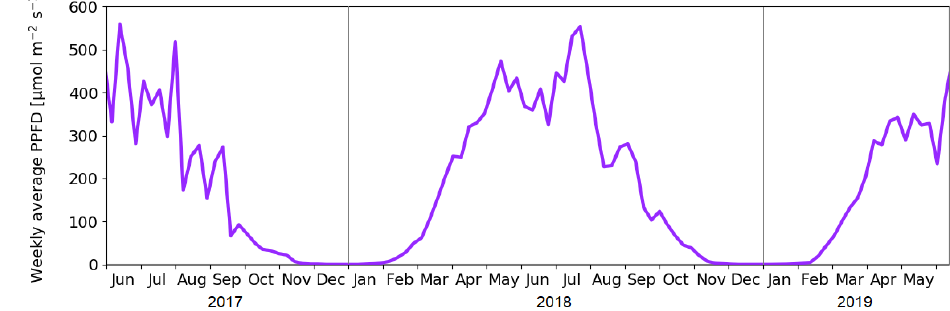
Figure 4. Weekly average photosynthetic photon flux density (PPFD) measured at Kaamanen.